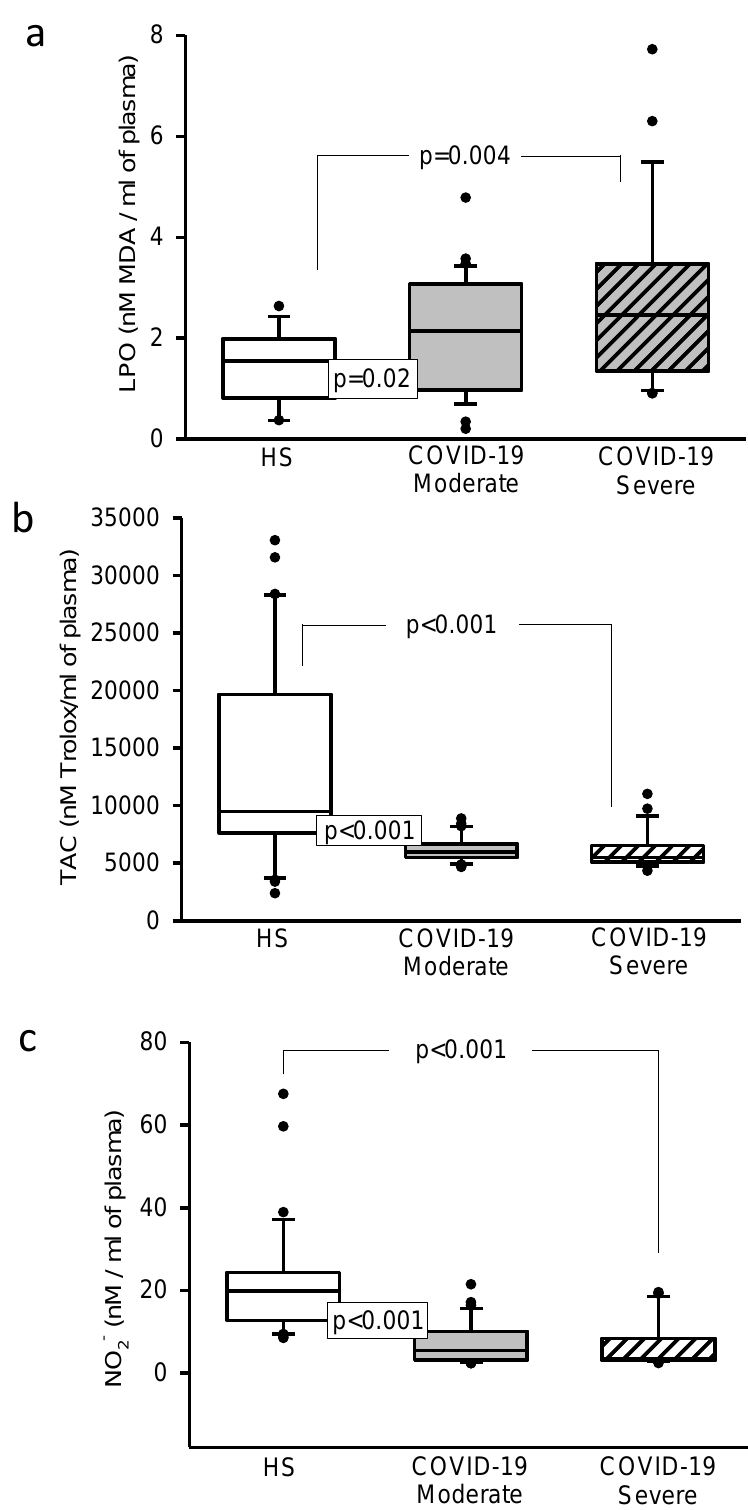
Figure 4. ( a ) The LPO index significantly increased in the moderate and severe COVID-19 patients in comparison with HS. ( b ) The TAC significantly decreased in the moderate and severe COVID-19 patients in comparison to HS. ( c ) The NO 2 – concentration significantly decreased in the moderate and severe COVID-19 patients in comparison with HS. Abbreviations: LPO = Lipid peroxidation, TAC = Total antioxidant capacity, NO 2 – = Nitrites.